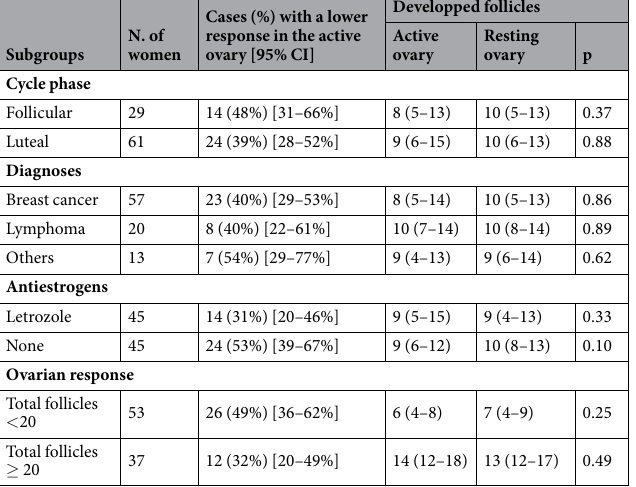
Table 2. Number of developing follicles in the active and resting ovaries: subgroup analyses. The 95% CI of the proportion of cases with lower response was calculated using a binomial distribution model The number of developing follicles is reported as median (interquartile range) and compared using the paired non parametric Wilcoxon